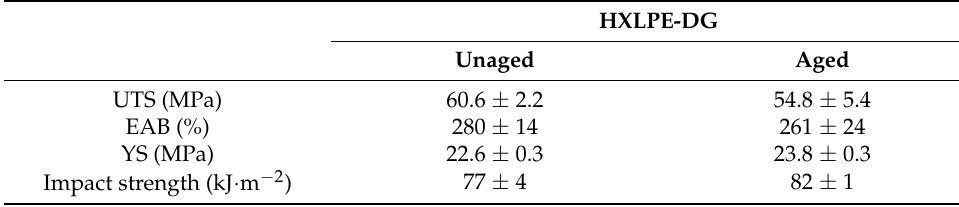
Table 1. The tensile properties of the materials.